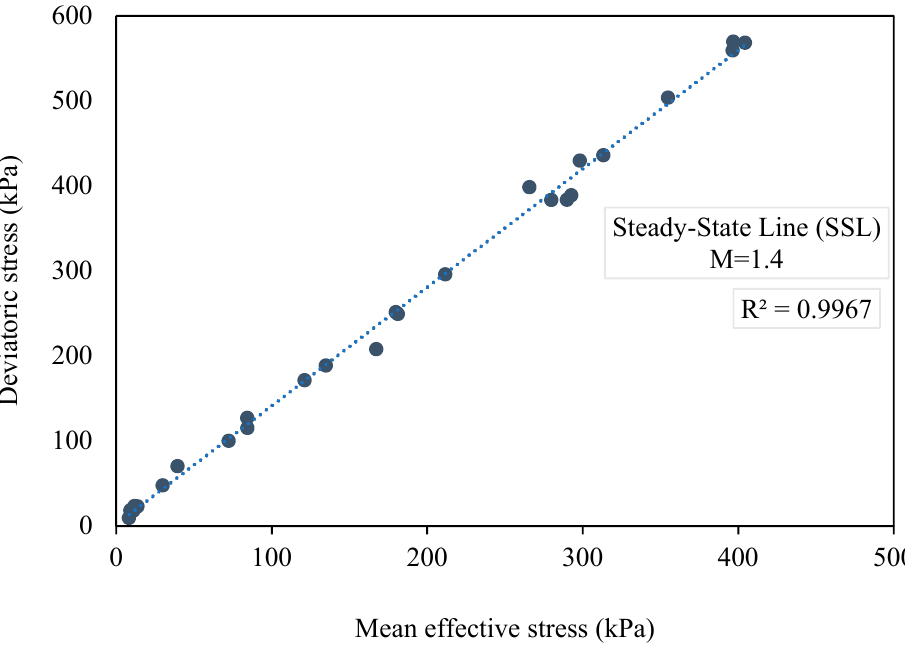
Figure 8. Steady state line in q–p’ plane.